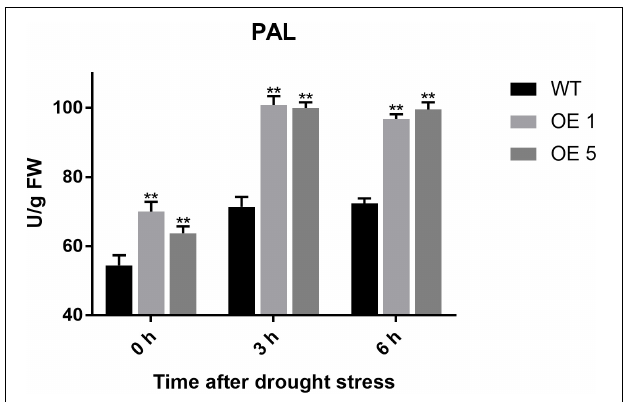
FIGURE 9 | PAL activity of WT and OE plants. The PAL activity of OE lines was significantly higher than that of WT plants after drought treatment. Vertical bars with * and ** represent significant differences compared with WT at each time point, analyzed by one-way ANOVA ( P ≤